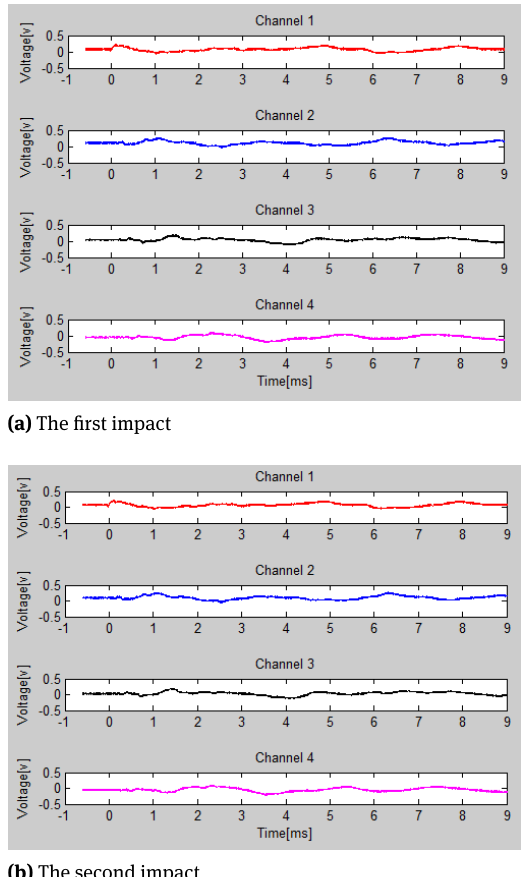
Figure 5: Example of original signals obtained from the impact